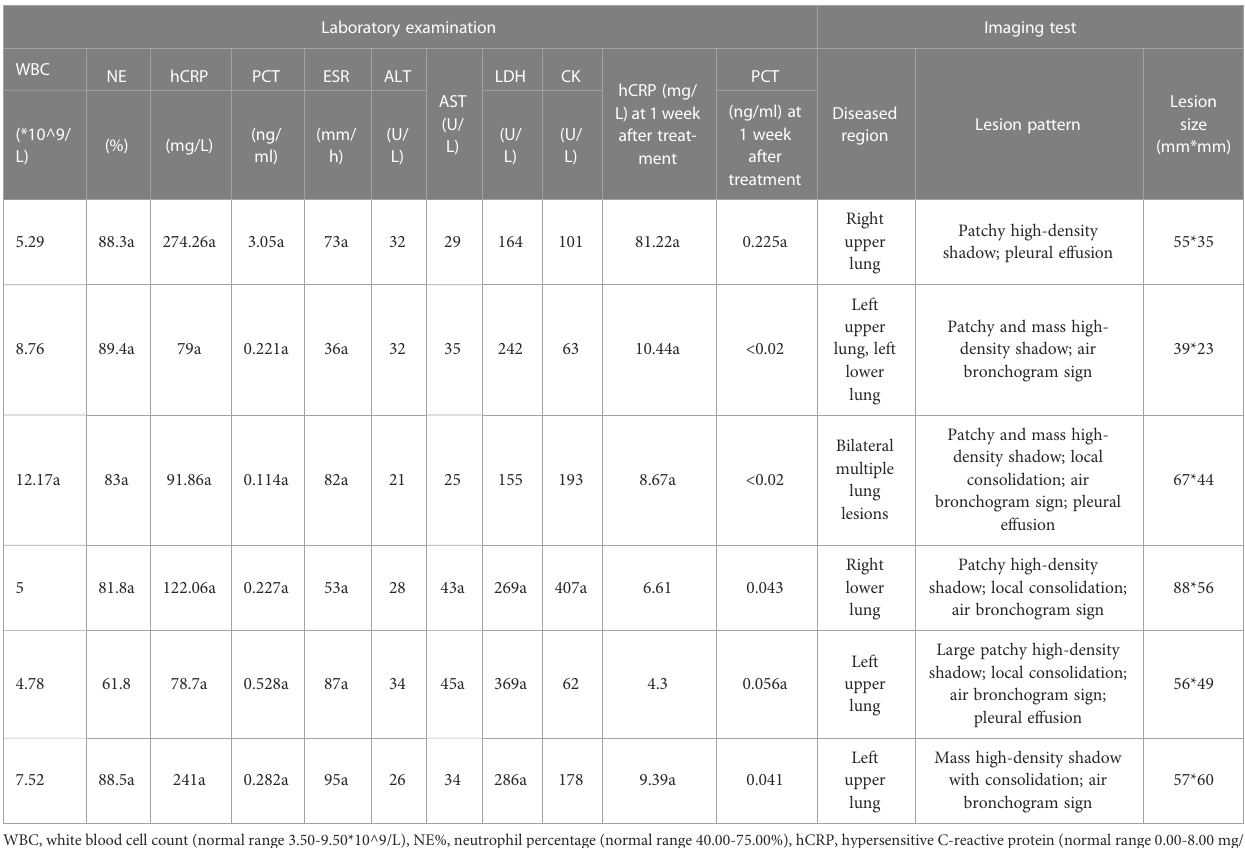
TABLE 2 Laboratory and imaging fi ndings in patients with Chlamydia psittaci